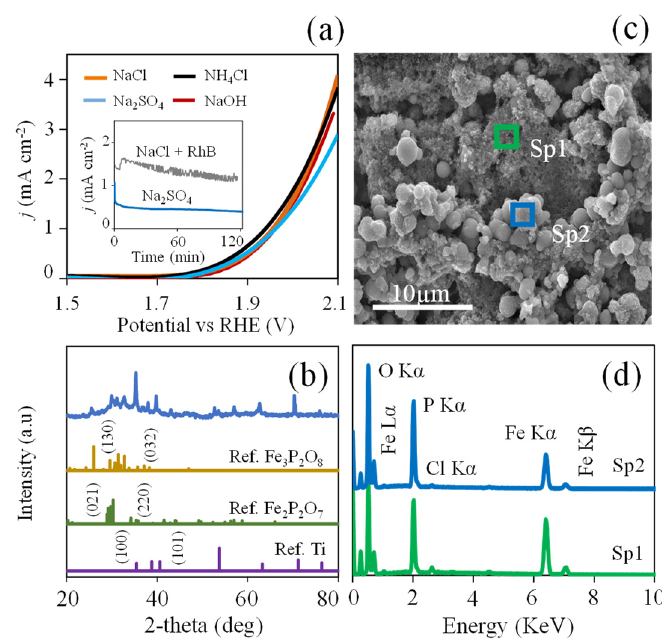
Figure 3. ( a ) LSV of Fe 2 P catalyst in 0.06 M NaCl, NH 4 Cl, NaOH and Na 2 SO 4 at pH 5. The inset in ( a ) is the I - t plot obtained for different electrolytes with and without 1 × 10 − 5 M RhB at 2.0 V vs. RHE. ( b ) XRD pattern of Fe 2 P film after the electrolysis. References are given with labels. ( c ) SEM image of Fe 2 P after electolysis (Cl − system). ( d ) EDS spectra recorded from the image in ( c ).